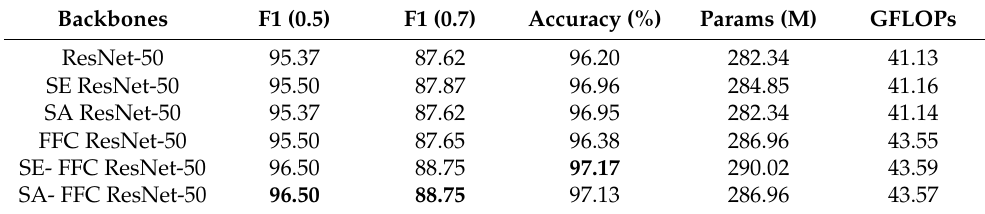
Table 3. Experimental results with different